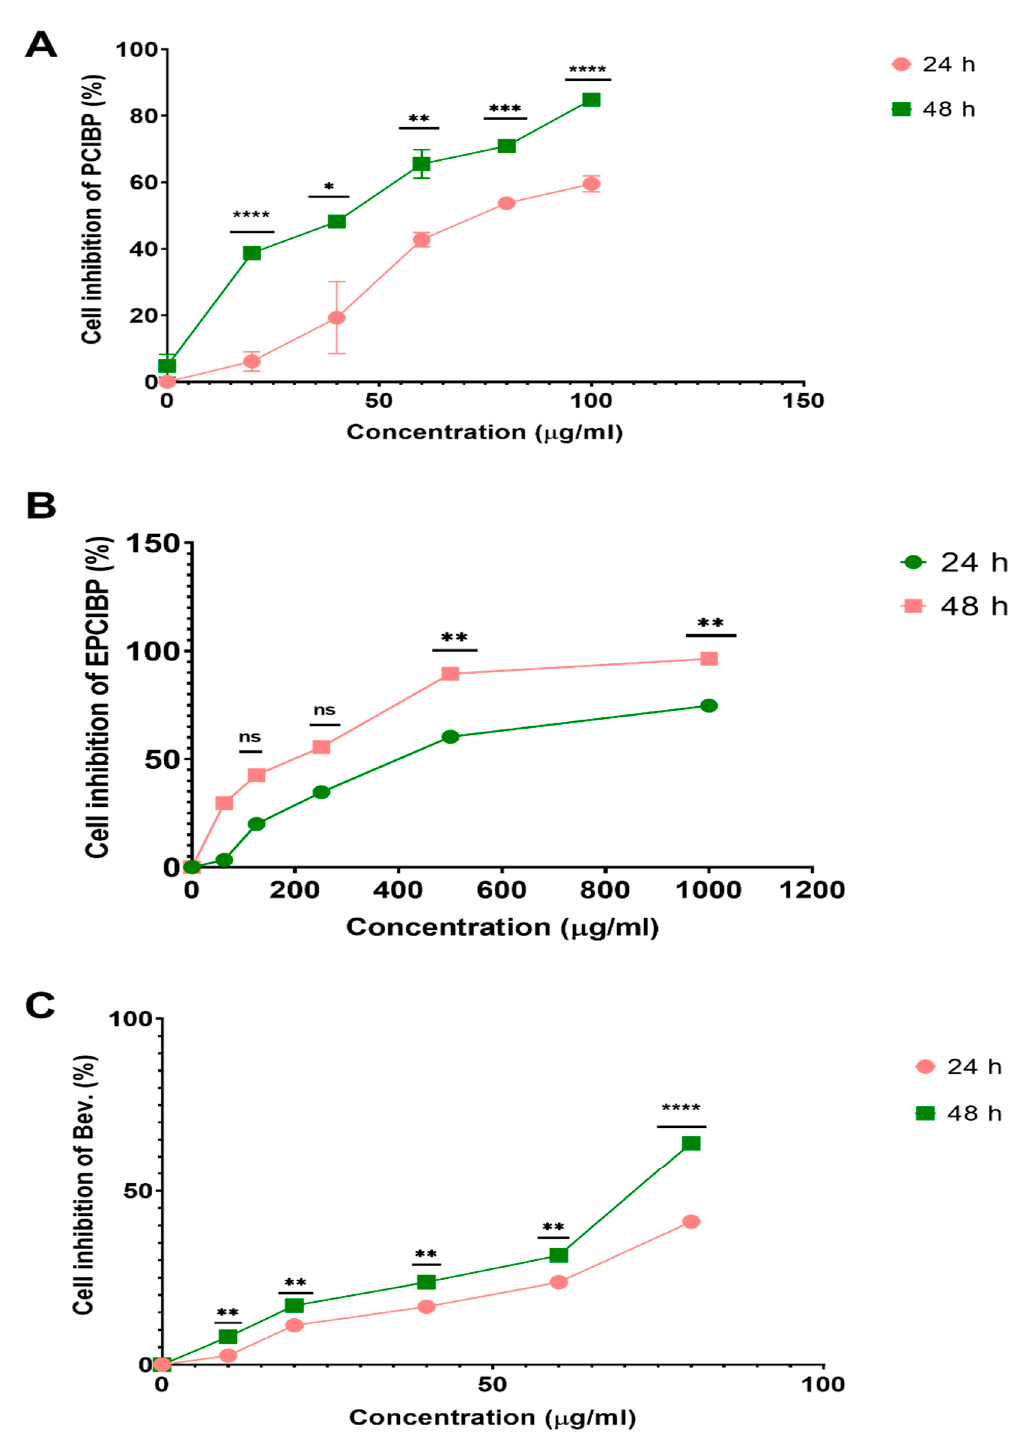
Figure 6. Line graph of the cell inhibition results on A549 lung cancer cells after incubation for 24 and 48 h with PCIBP, EPCIBP, and Bev. treatments. The percentage of treated cells was measured by MTT cytotoxicity assay. ( A ) PCIBP for each point compared with the other points by multiple t-tests where * p ≤ 0.01, ** p ≤ 0.001, *** p ≤ 0.0001, **** p ≤ 0.00001. ( B ) EPCIBP for each point compared with the opposite point by multiple t -tests where ns: nonsignificant, ** p ≤ 0.001, ( C ) Bev. for each point compared with the other points by multiple t -tests where ** p ≤ 0.001, **** p ≤ 0.00001.